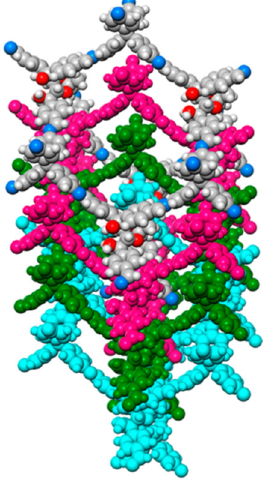
Figure 14. Fold interpenetration of a dia net along the a-axis. Reprinted (adapted) with permission from [54]. Copyright 2018 American Chemical Society.